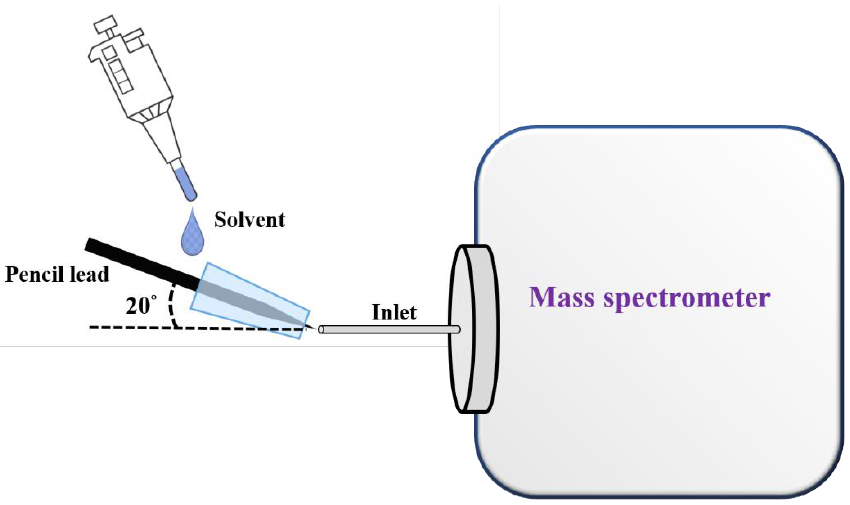
Figure 2. Cartoon illustration of the setup of a SPME fiber online coupled with CFI-MS.